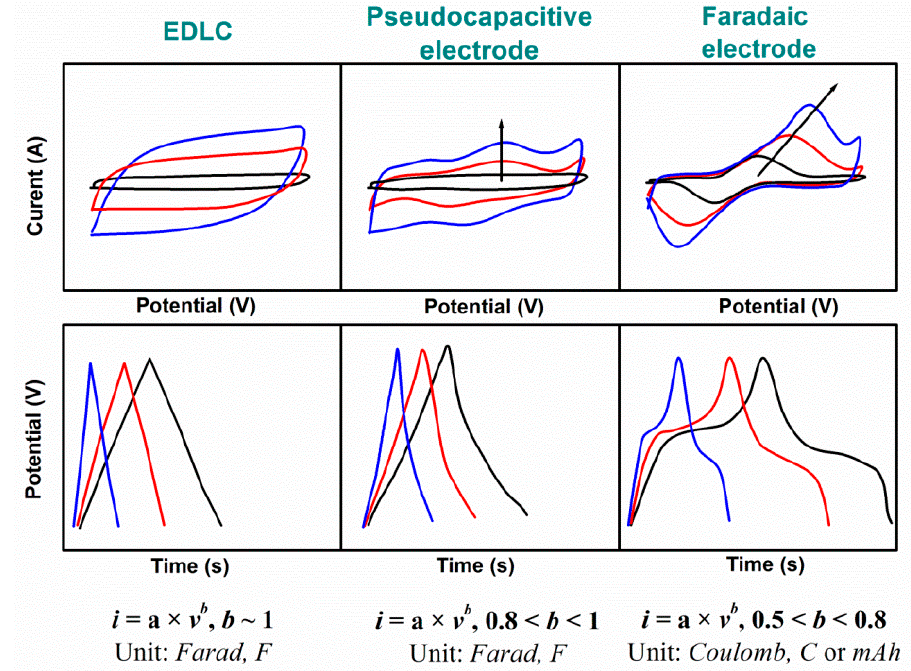
Figure 3. Schematic view of typically reported cyclic voltammograms (CV) and galvanostatic charge and discharge (GCD) curves and applicable information for the G/rGO-CNT electrodes. and discharge (GCD) curves and applicable information for the G/rGO-CNT